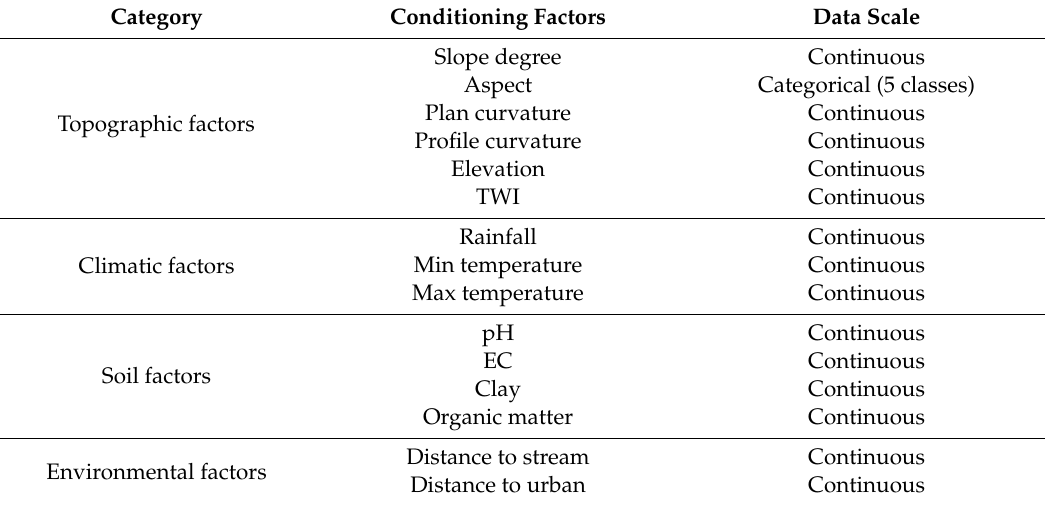
Figure 2. Conditioning factor maps of the study area: slope ( A ), aspect ( B ), plan curvature ( C ), profile curvatures ( D ), elevation ( E ), topographic wetness index (TWI) ( F ), rainfall ( G ), Min temperature ( H ), Max temperature ( I ), pH ( J ), electrical conductivity (EC) ( K ), organic matter ( L ), percentage of clay ( M ), distance to stream ( N ), and distance to urban ( O ). Table 1. Habitat suitability conditioning factors in the present study.